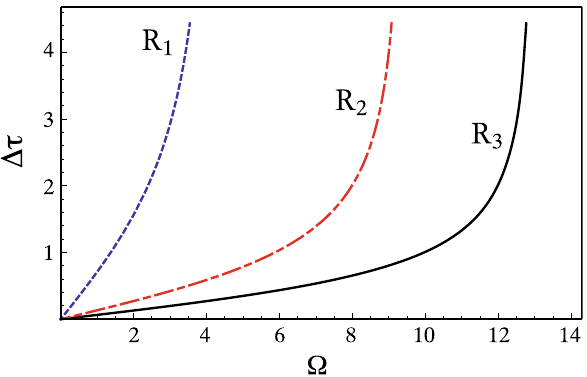
Fig. 8 Time difference Δτ between the counter-propagating beams detected by a comoving observer as a function of the angular velocity Ω , for various separation distances between the source and an ideal rotating interferometer. The plots are for R 1 = 7 × 10 7 , R 2 = 3 × 10 7 and R 3 = 2 × 10 7 considering λ = 2 × 10 10 and Q = 2 × 10 7 (all values are in arbitrary length